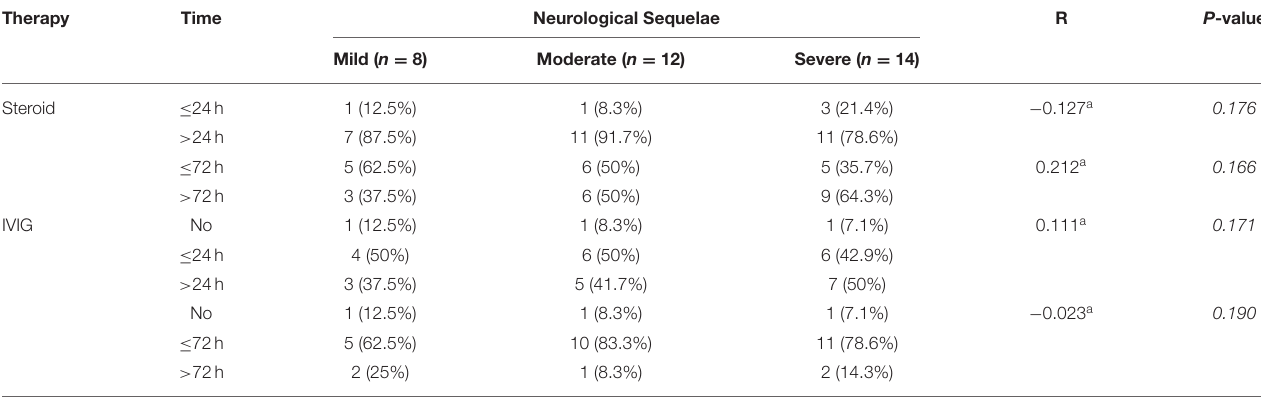
TABLE 4 | The association between steroid and IVIG therapy activation time and neurological sequelae of ANE. Therapy Time Neurological Sequelae R P